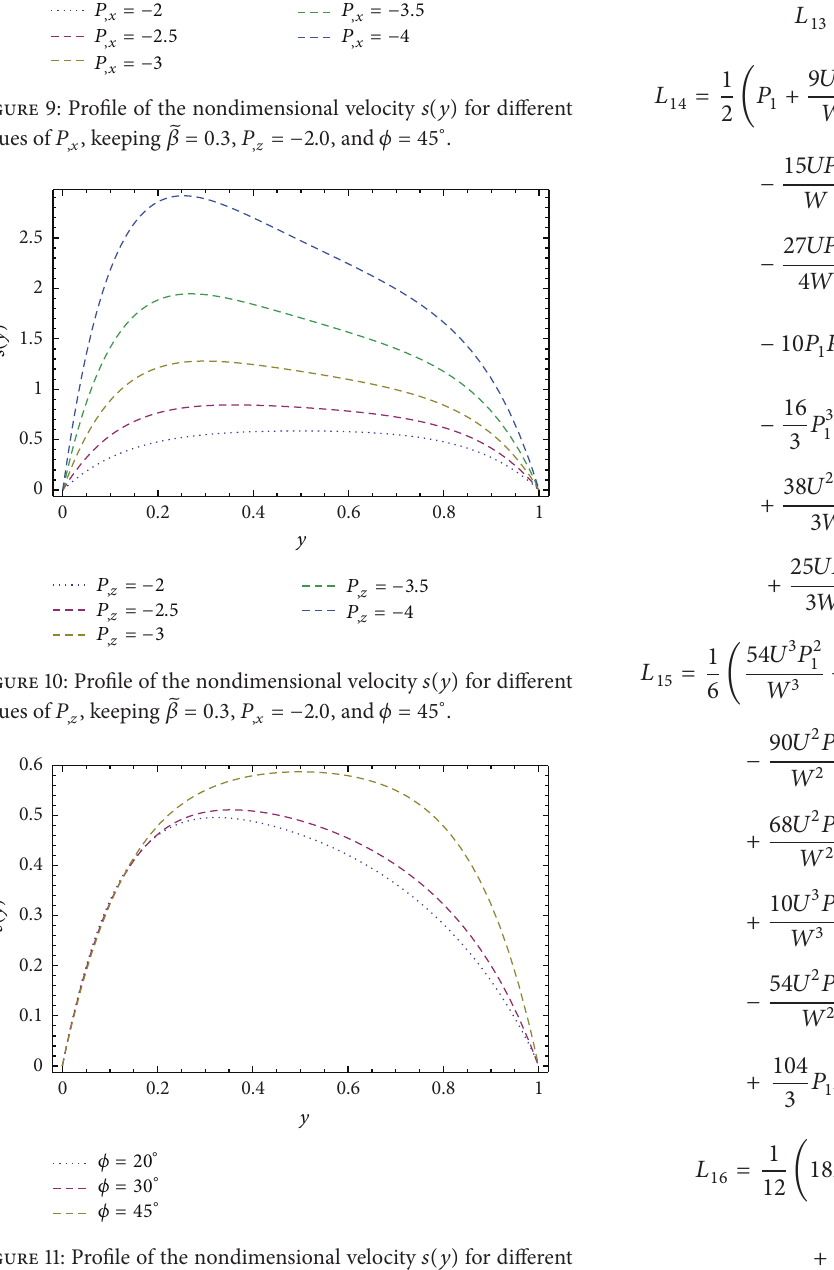
Figure 11: Profile of the nondimensional velocity 𝑠(𝑦) for different ̃𝛽 = 0.3 , 𝑃 ,𝑥 = −2.0 , and 𝜙 = 45 ∘ values of 𝑃 ,𝑧 , keeping